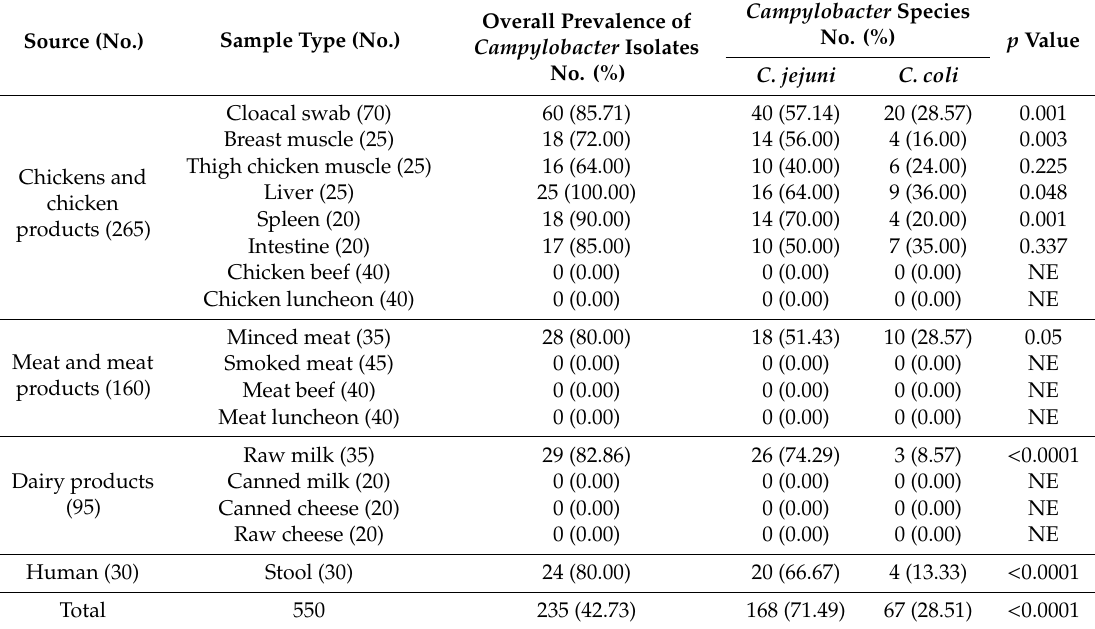
Table 1. Prevalence of Campylobacter species isolated from animal and human